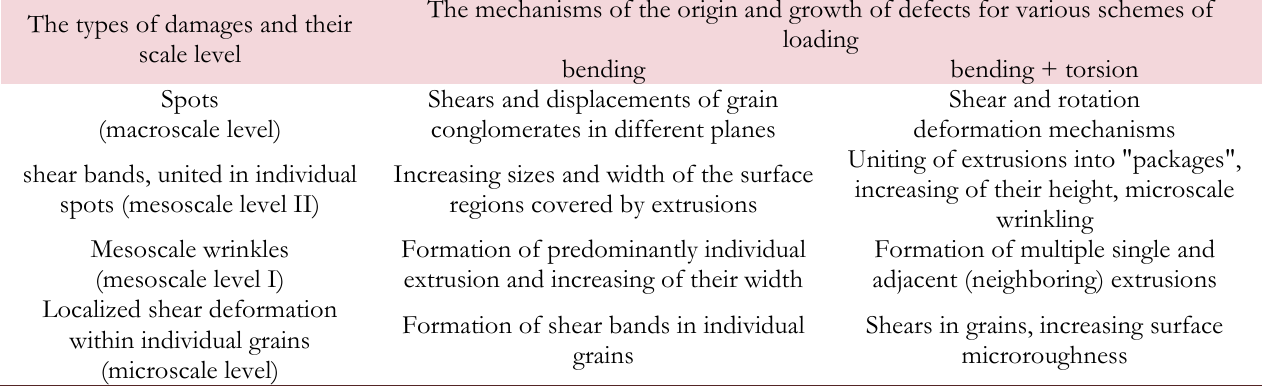
Table 1: Scale levels and mechanisms of damage